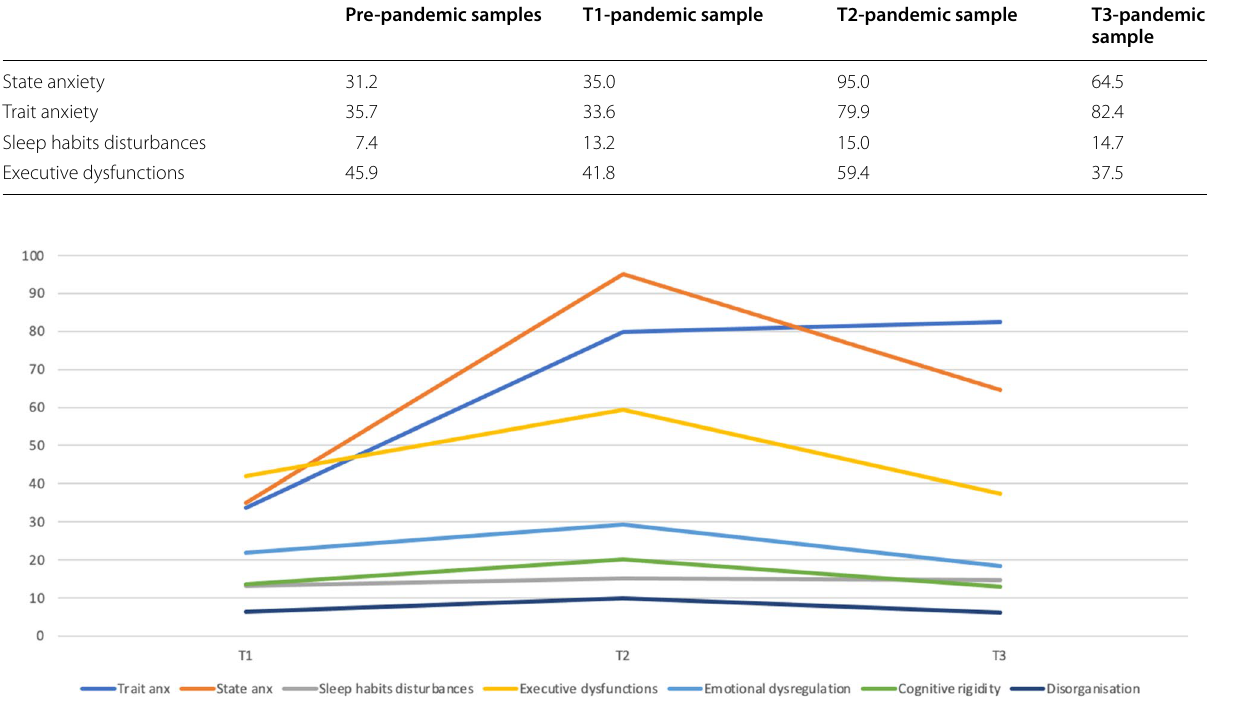
Fig. 1 This graph shows the means of the outcome variables (trait/state anxiety, sleep habits disturbances, executive dysfunctioning, emotional dysregulation, cognitive rigidity and disorganisation) during the three times of